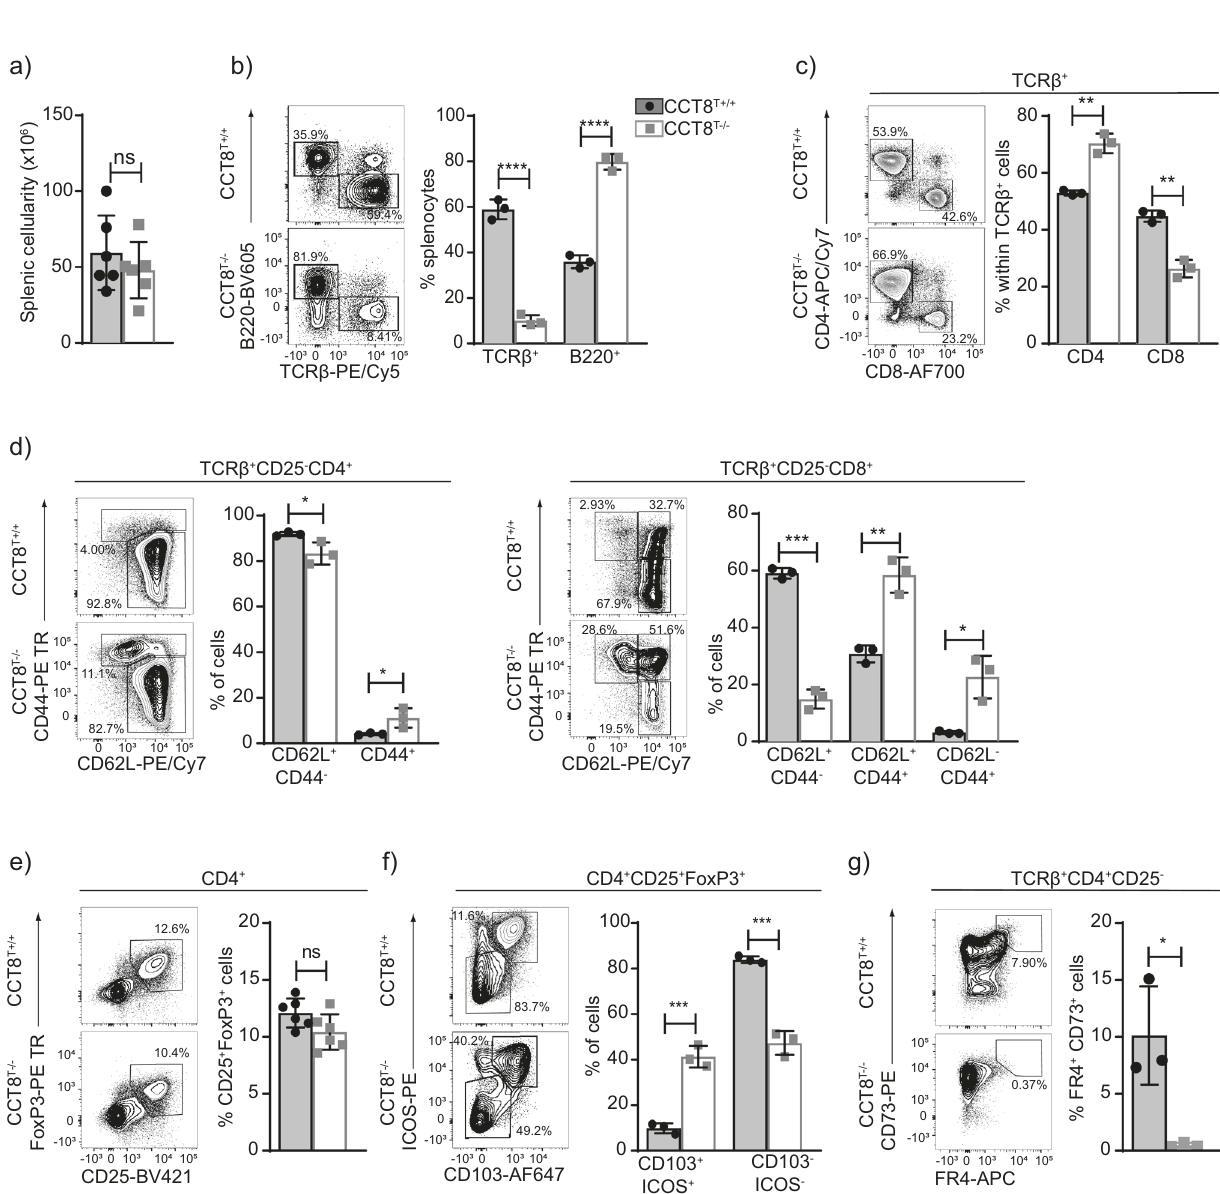
Fig. 1 The role of CCT8 in thymocytes. a CCT8 protein detection by western blot. Values shown are relative to the detection in DN thymocytes. b Total thymic cellularity, and c thymocyte subpopulations in 6-week-old CCT8 T + / + (grey bars) and CCT8 T − / − mice (white bars) as de fi ned by CD4 and CD8 cell surface expression on lineage-negative thymocytes. d Positive thymocyte selection and maturational stages (R2: TCR β low CD69 − ; R3: TCR β low CD69 + , R4: TCR β hi CD69 + and R5: TCR β hi CD69 − ) and progression between sequential stages. e Non-signalled thymocytes (activated caspase 3 − expression among CD5 − TCR β lo − thymocytes). Negative thymocyte selection in the cortex. f Wave 1a (TCR β lo/hi CCR7 - SPCD4 + SPCD8 + ), and g wave 1b (TCR β hi SPCD4 + CCR7 - CD69 + CD24 + ). Negative selection in the medulla. h Wave 2a (TCR β hi SPCD4 + CCR7 + CD69 + CD24 + ), i and wave 2b (TCR β hi SPCD4 + CCR7 + CD69 − CD24 − ). j Late-stage maturation of single positive TCR β hi CCR7 + thymocytes. Phenotypic analysis (M1: CD69 + MHC + , M2: CD69 − MHCI + ). k TNF α production by M2 SPCD4 and SPCD8 cells. l Total thymic T reg cells (CD25 + Foxp3 + ), and m recirculating T reg among thymic CD25 + Foxp3 + cells. Left panels in ( c , d , f – i , l , m ) display representative contour plots of data shown in bar graphs ( b – h ). * p < 0.05, ** p < 0.01, *** p < 0.001, **** p < 0.0001 (Student ’ s t -test, ( b – m ), adjusted for multiple comparison panel ( j )). Data shown in ( a ) are representative of two independent experiments. Data in bar graphs show mean ± SD representative two panels ( b – e and j – m ) and three ( f – i ) independent experiments, respectively, with three replicates each. See also Fig. S1.